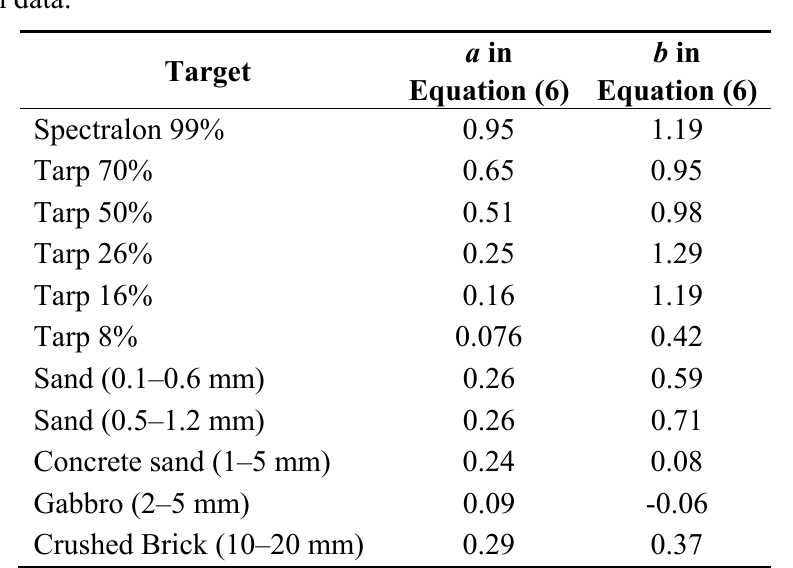
Table 3. Parameters a,b of the correction model (Equation (6)) for each target. Grain sizes for the sand/gravel targets are also included. The relative model fit (root-mean-square, RMS) for the samples was 1%–4%, except 7% for brick, for which there was large inaccuracy in